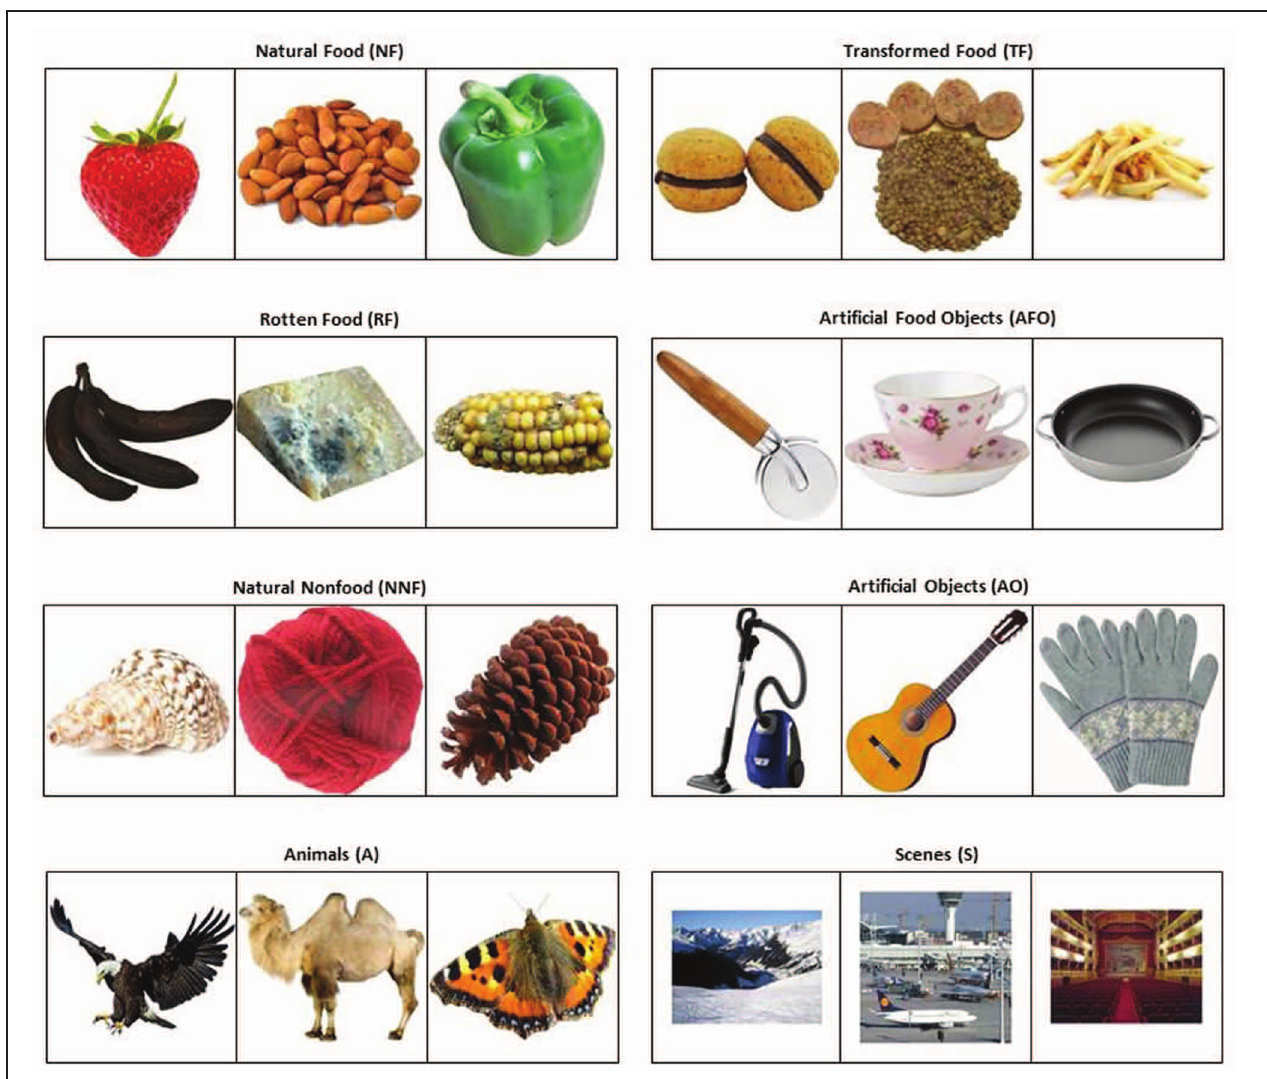
FIGURE 1 | Examples of the stimuli from the database. Tree examples of items from each category of stimuli. Information regarding the examples is reported in the Appendix.